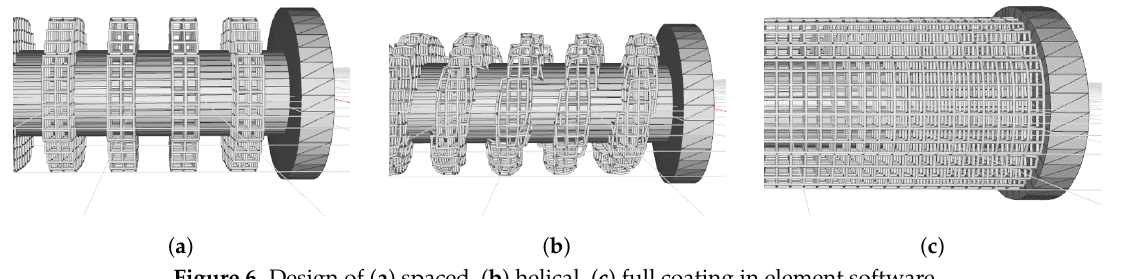
Figure 6. Design of ( a ) spaced, ( b ) helical, ( c ) full coating in element